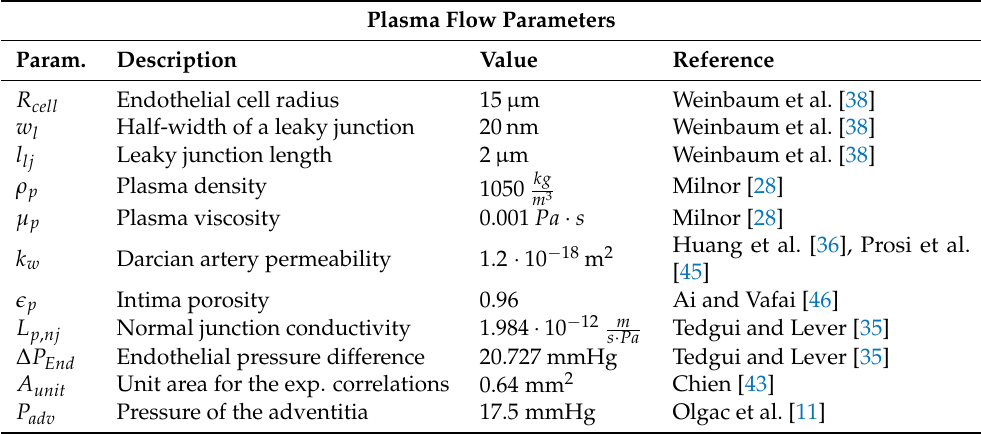
Table 2. Parameters to model plasma flow across the endothelium. Plasma Flow